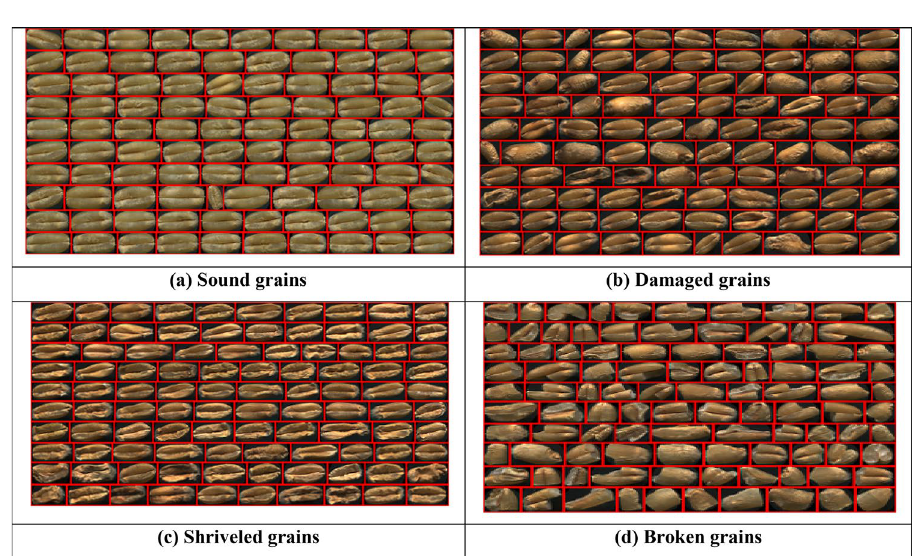
Figure 3. Segmented images of wheat refractions (a) sound grains, (b) damaged grains, (c) shriveled grains, (d) broken